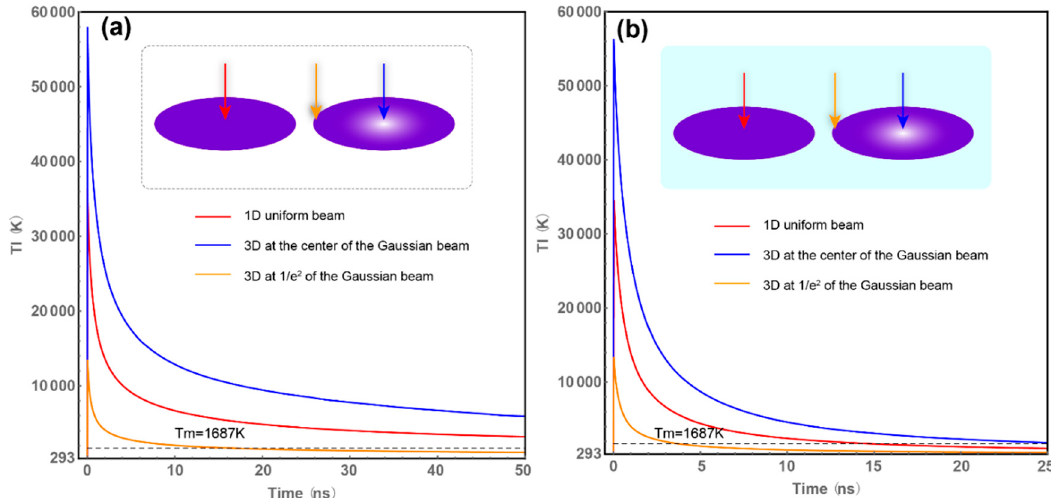
Figure 4. Temperature evolutions of the lattice at the top surface of silicon foil irradiated by 1D uniform beam and 3D Gaussian beam ( a ) without liquid cooling, ( b ) with liquid cooling.